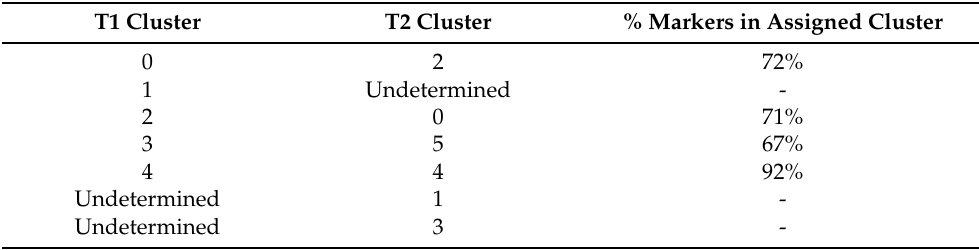
Table 1. Matching clusters between T1 and